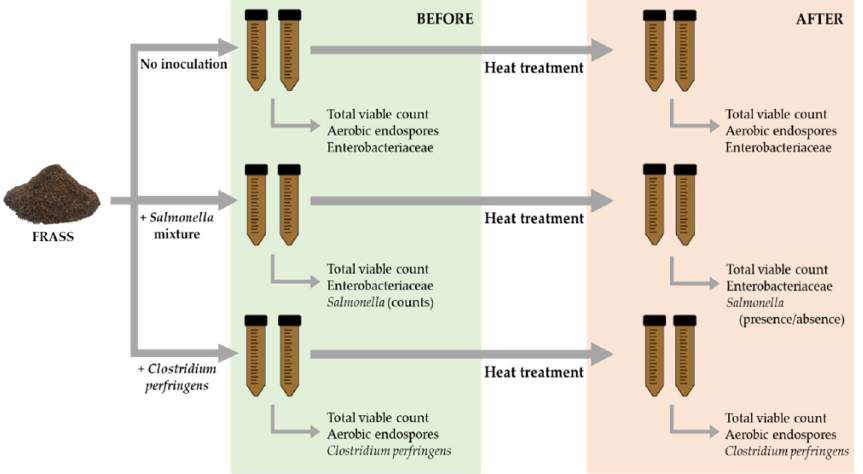
Figure 1. Design of one heat treatment (experiment) with three different inoculation conditions and associated analyses before and after the heat treatment. The experiment was performed three times consecutively, using other subsamples of the frass.